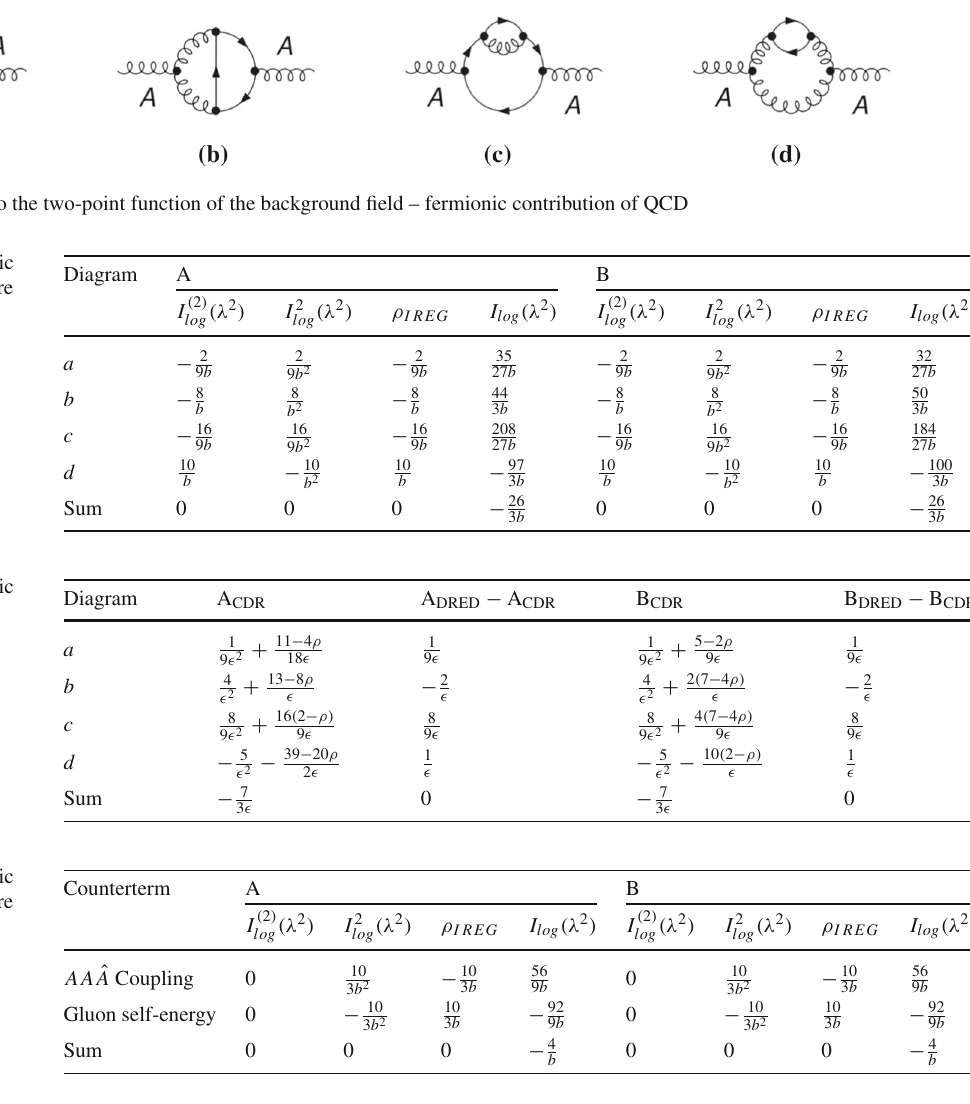
Fig. 4 Two-loop corrections with (cid:5) -scalar